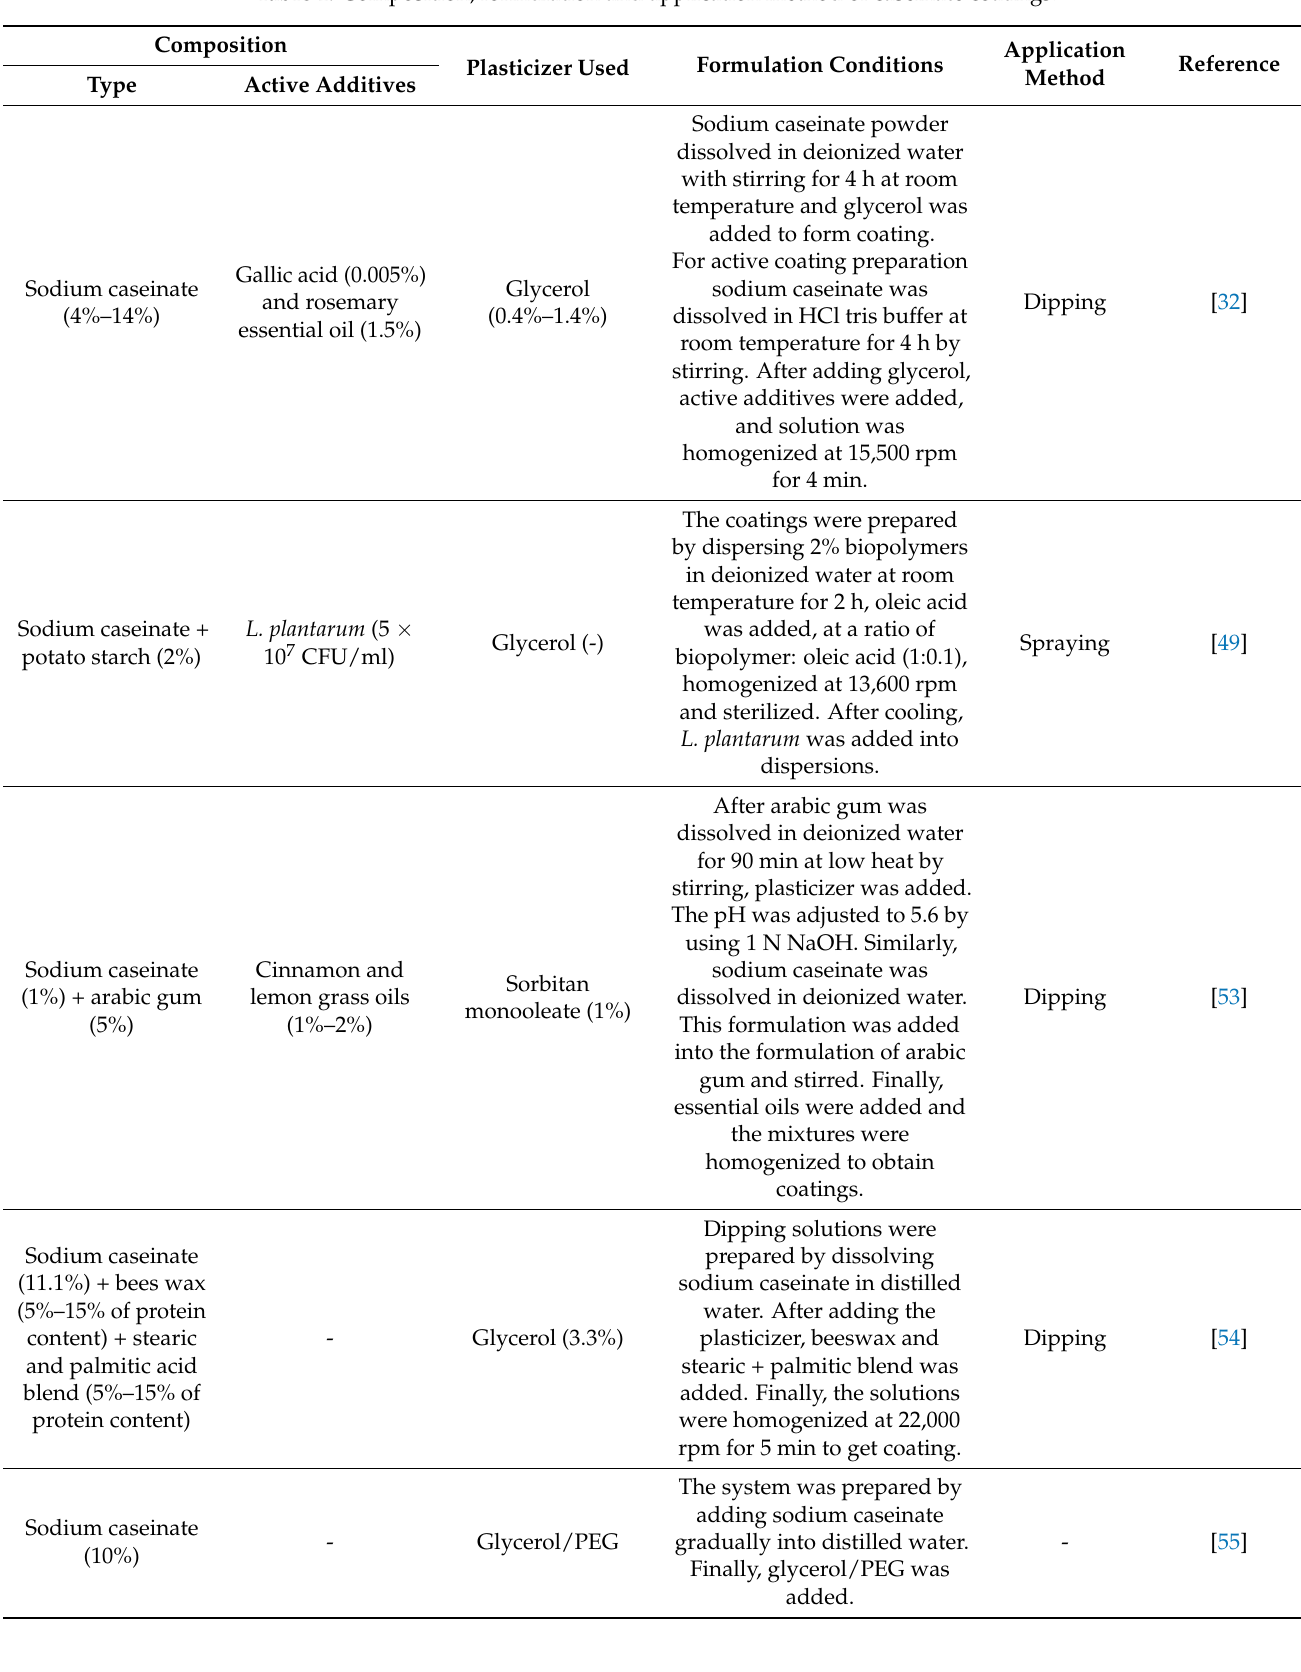
Table 1. Composition, formulation and application method of caseinate